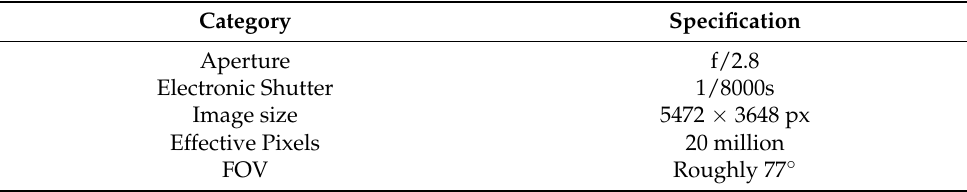
Table A1. Specifications of the Hasselblad UAV digital camera used in this